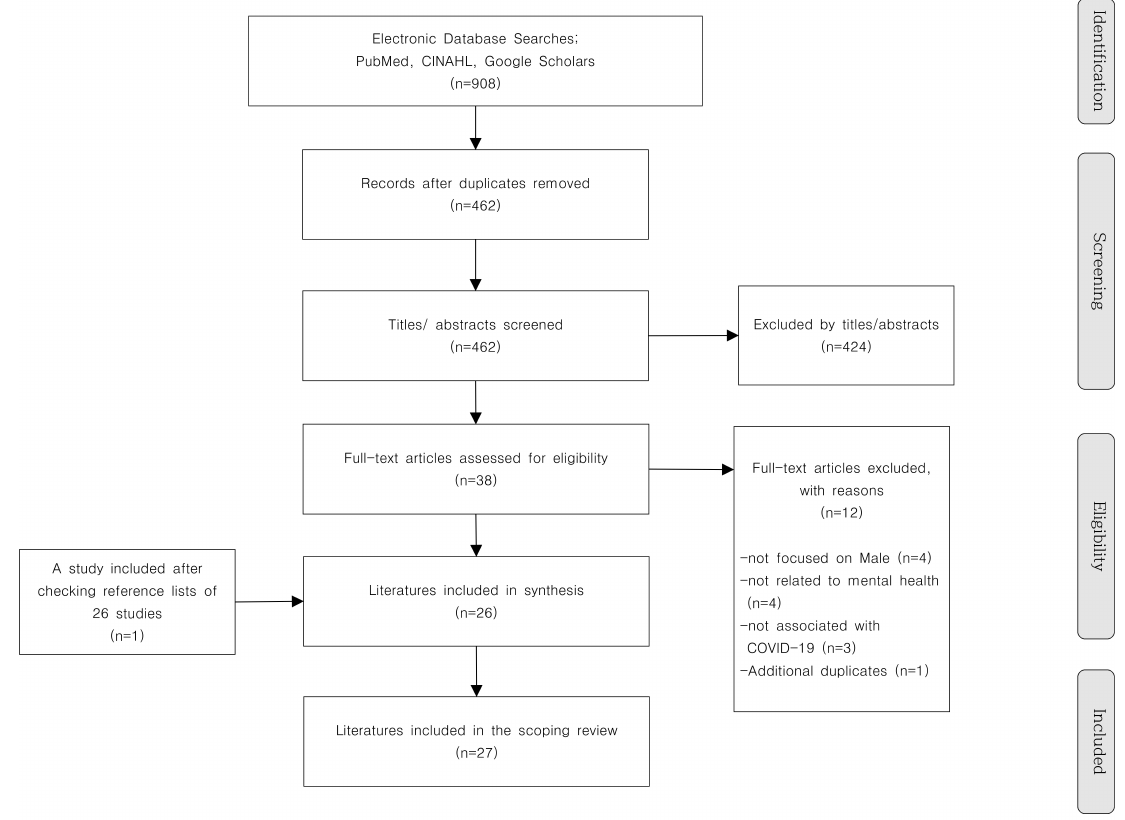
Fig. 1. Data collection, selection, and extraction